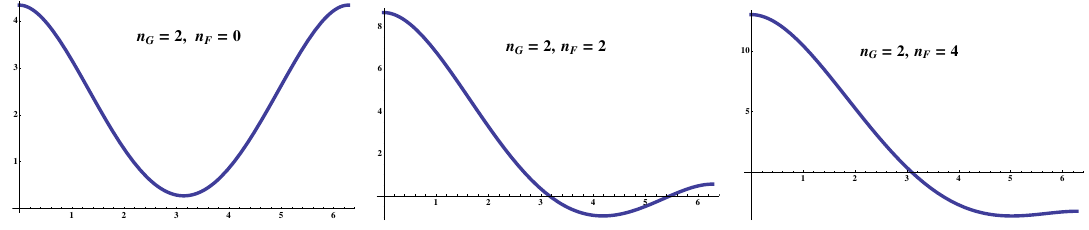
Figure 1 . The shaded region is the a(cid:14)ne Weyl chamber of su (3). The horizontal and vertical axes are (cid:30) 1 and (cid:30) 2 , respectively. We take the simple roots to be (cid:11) 1 = The blue circles indicate the location of the two degenerate vacua in the case ( n G = 2) (cid:8) The red square is the center symmetric point, which is the vacuum location for 1 (cid:20) n G (cid:20) 5 adjoint fermions.